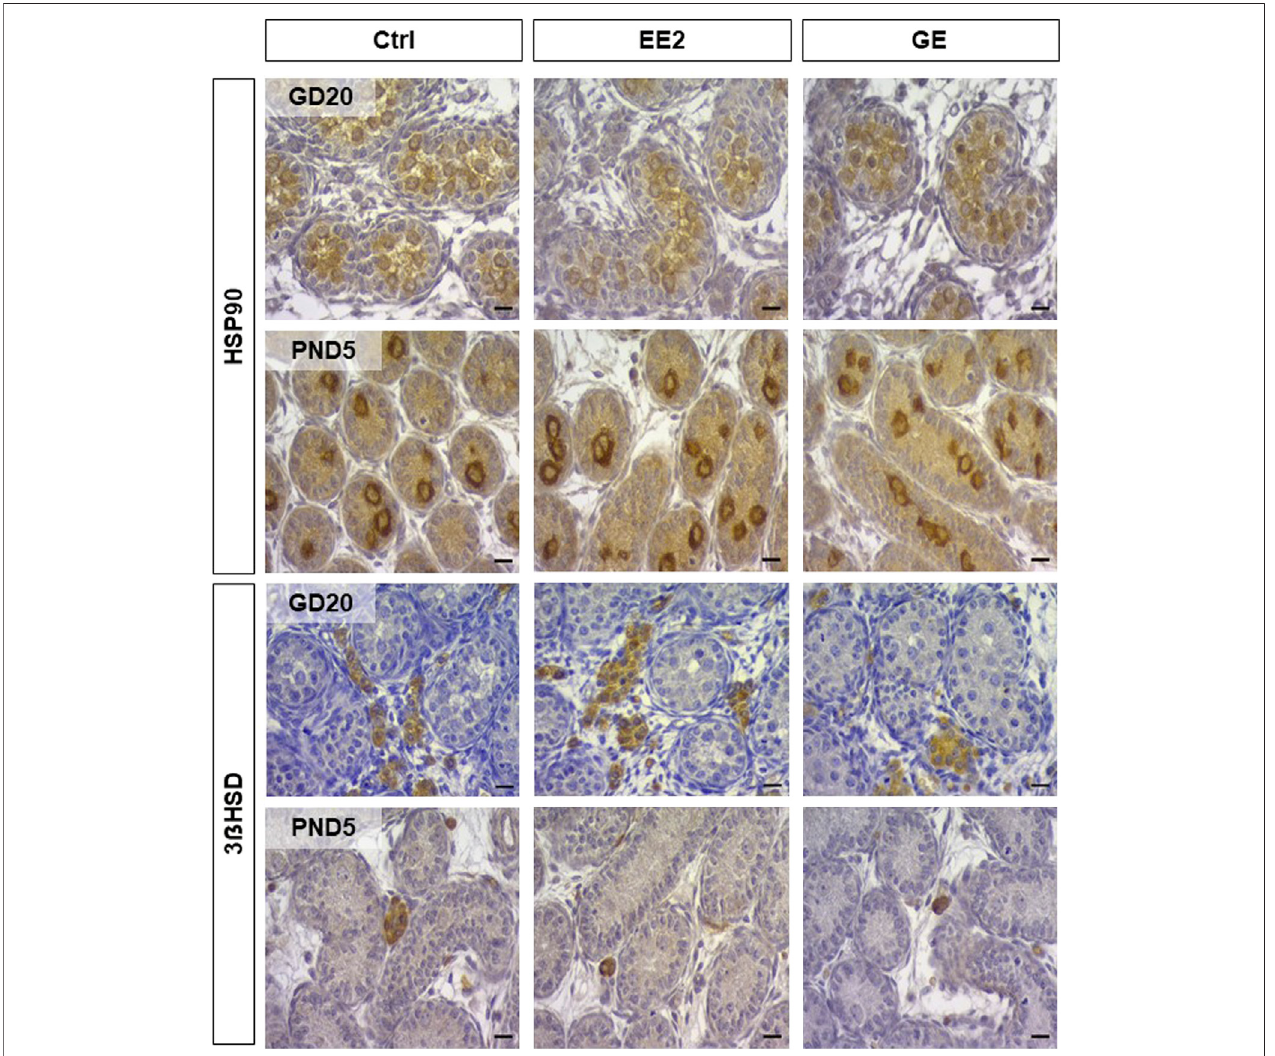
FIGURE 2 | Analysis of testicular histology after in utero exposure to EE2 or GE. Representative illustrations of testicular sections collected after exposure to ethynilestradiol (EE2) or Genistein (GEN) at Gestational Day 20 (GD20) and post-natal day 5 (PND5). Top rows illustrate staining for Heat shock protein 90 (HSP90) in developing germ cells, while bottom rows illustrate staining for 3ß Hydroxy-steroid deshydrogenase (3ßHSD) in Leydig cells. Scale bar represents 10 µm.